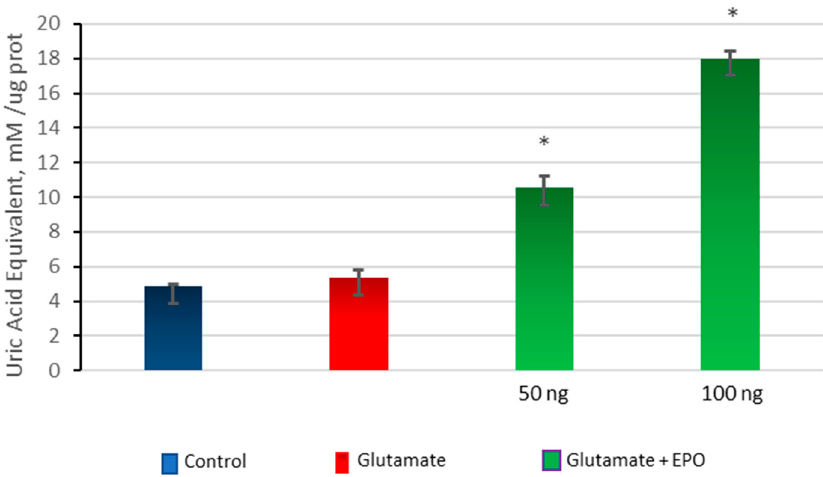
Figure 5. Total antioxidant activity . Cortical cells treated with 100 µM glutamate for 15 min without or with neuroEPO (50 ng/mL or 100 ng/mL) for 24 h. The treatment with glutamate does not significantly modify the levels of antioxidant activity compared with the levels of antioxidant activity of the cells not treated with glutamate (control). NeuroEpo induces a significant increase ( p < 0.001) in the antioxidant activity, which is dependent on the concentration of neuroEpo, compared both in the cells treated with glutamate and in the untreated cells (control). Data are the mean ± SEM values from 3 independent experiments; * p ≤ 0.001.